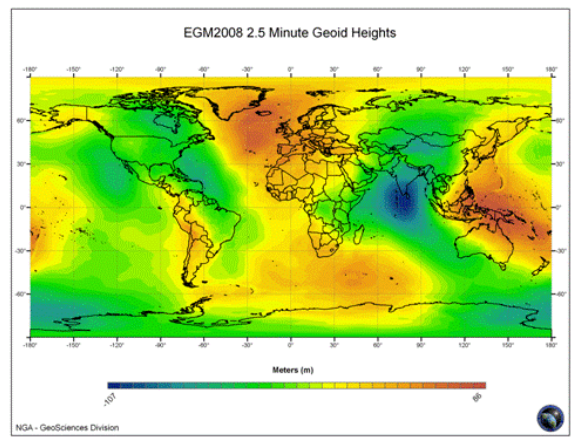
Figure 3. EGM2008 2.5 minute geoid heights